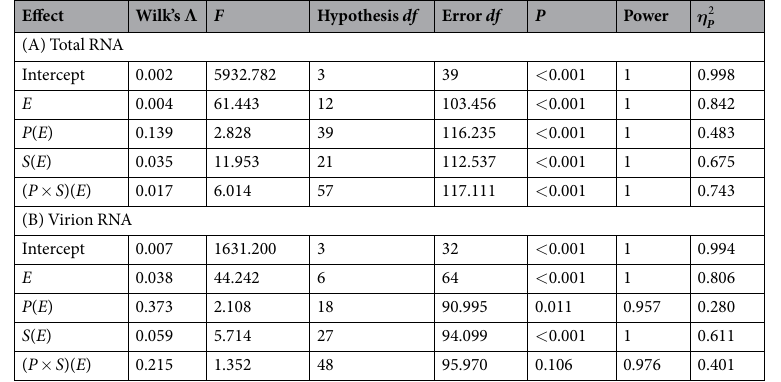
Table 3. Results of the MANOVA analysis for the RNA frequencies estimated from total and from virion RNA extractions in experiments with 1:1:1 input ratio done in five different host species. The model fitted is shown